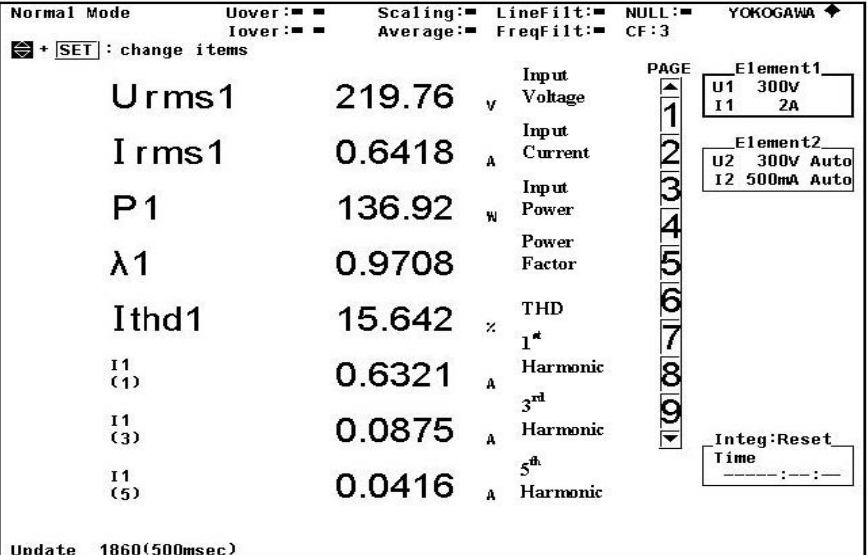
Figure 24. Electrical characteristics of the proposed converter.